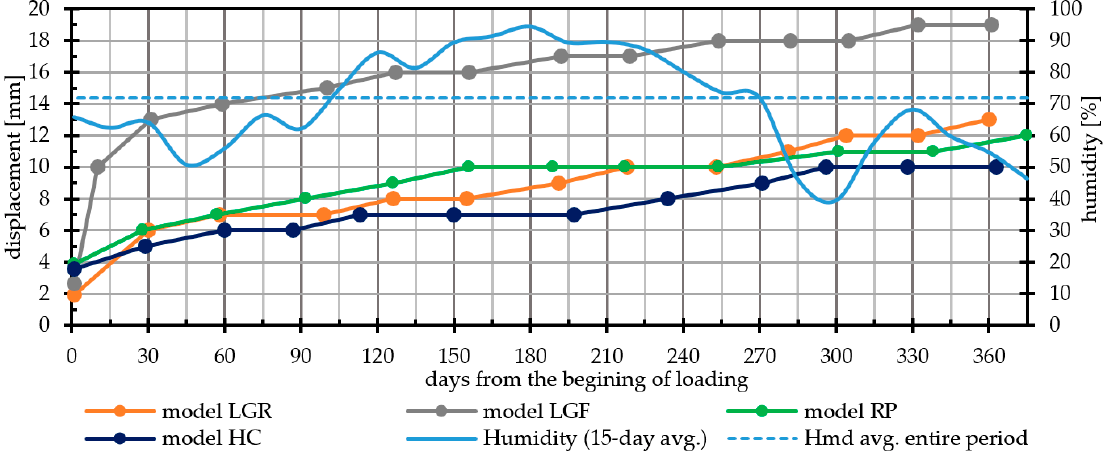
Figure 19. Maximum displacement of models during the load period.